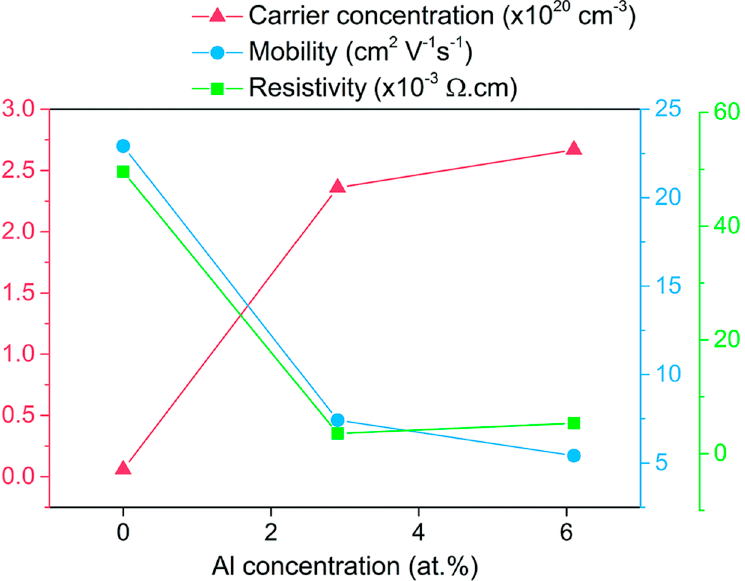
Figure 3. Hall effect results showing the change in carrier concentration, carrier mobility, and resistivity upon doping of ZnO with Al. Reproduced with permission from ref. [52].